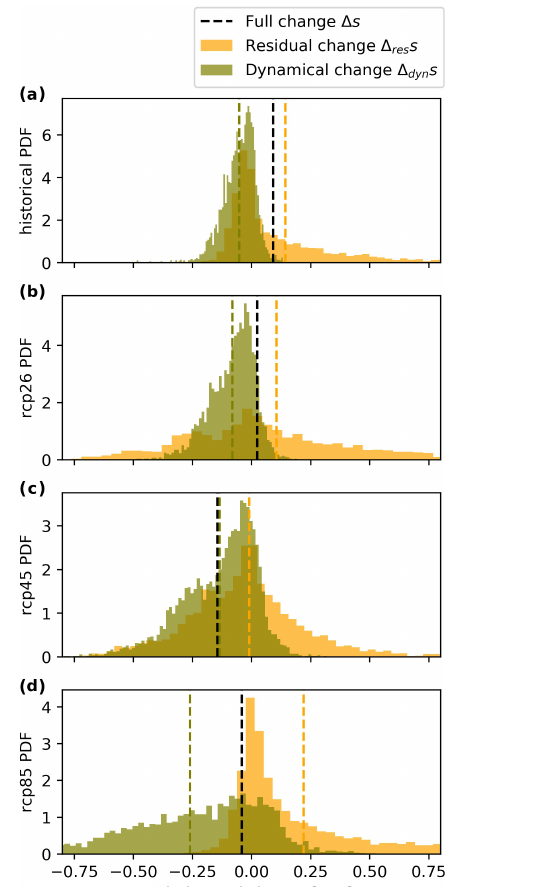
Figure 2. Probability density function of wind speed changes over land (excluding Antarctica and Greenland). Dashed lines mark the mean change. Values correspond to second and third columns in Fig.